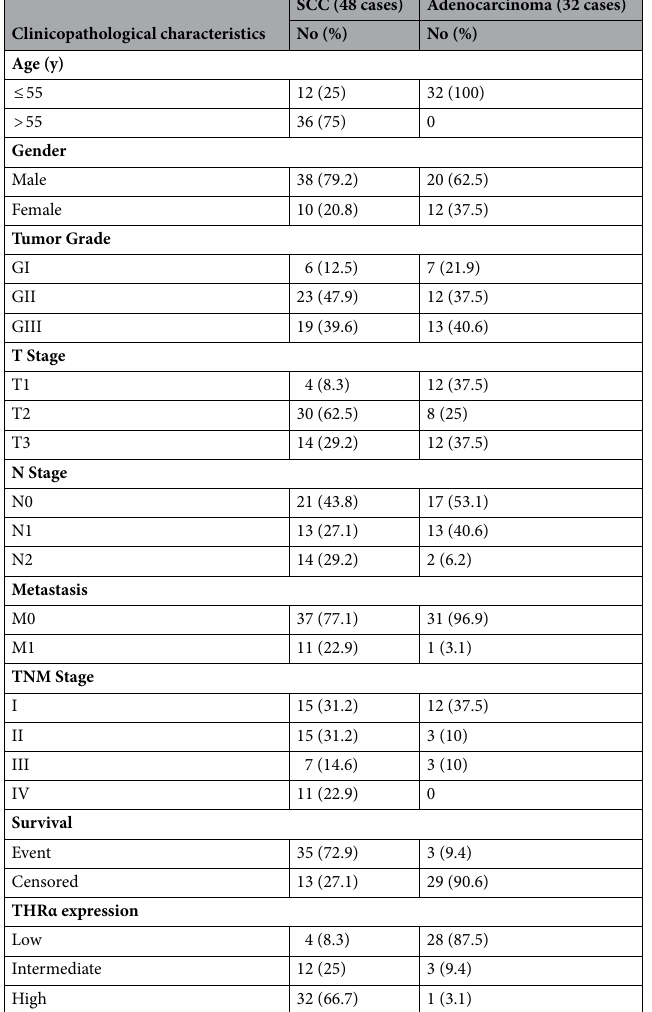
Table 1. The clinicopathological characteristics of NSCLC cases (No =